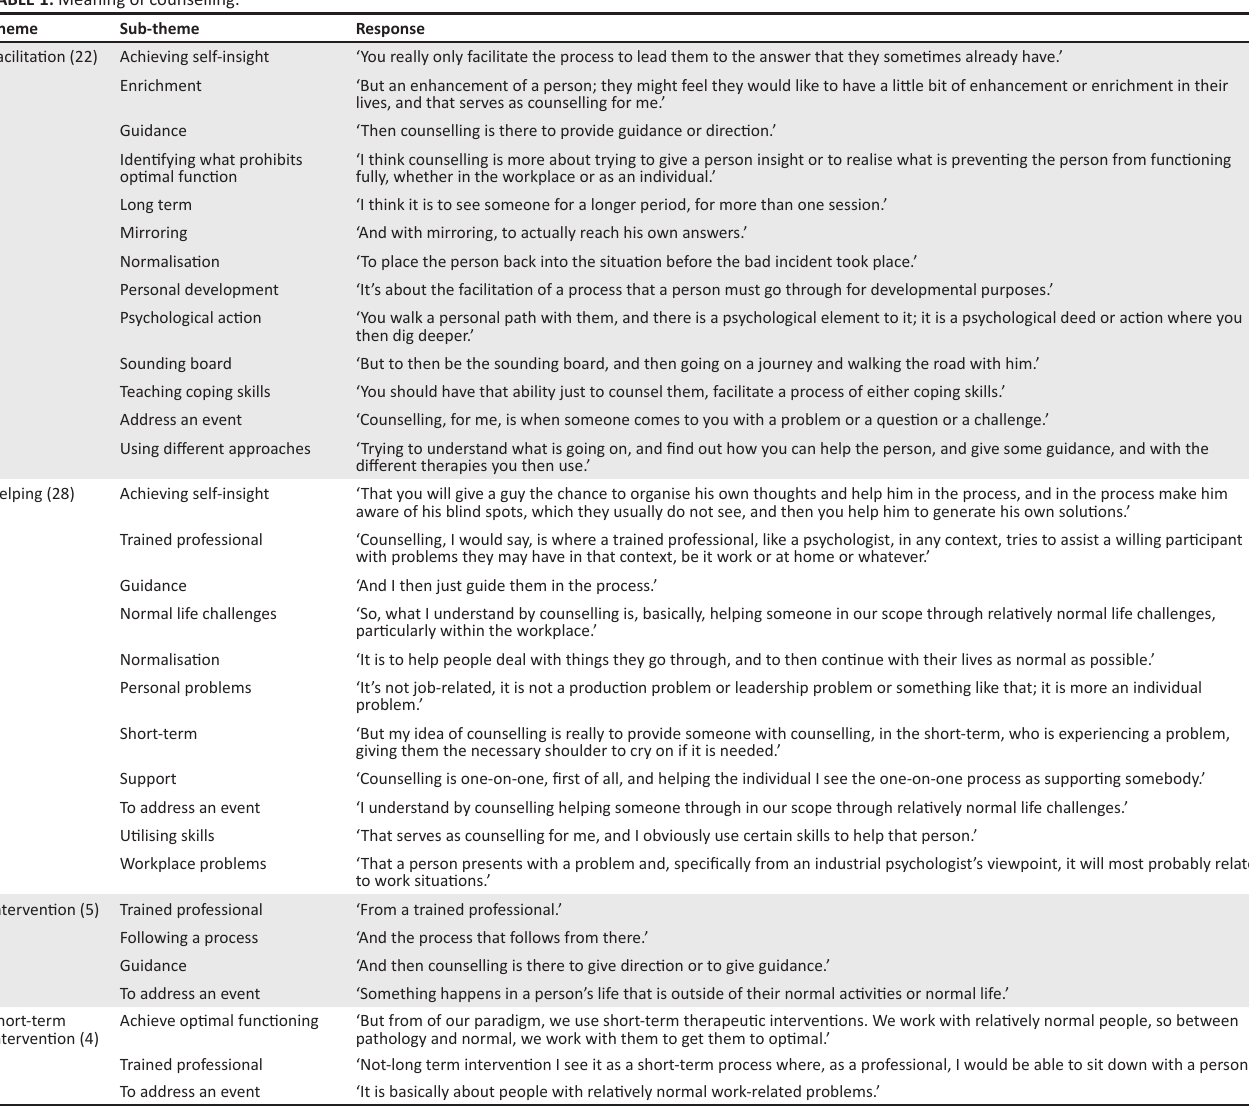
TABLE 1: Meaning of